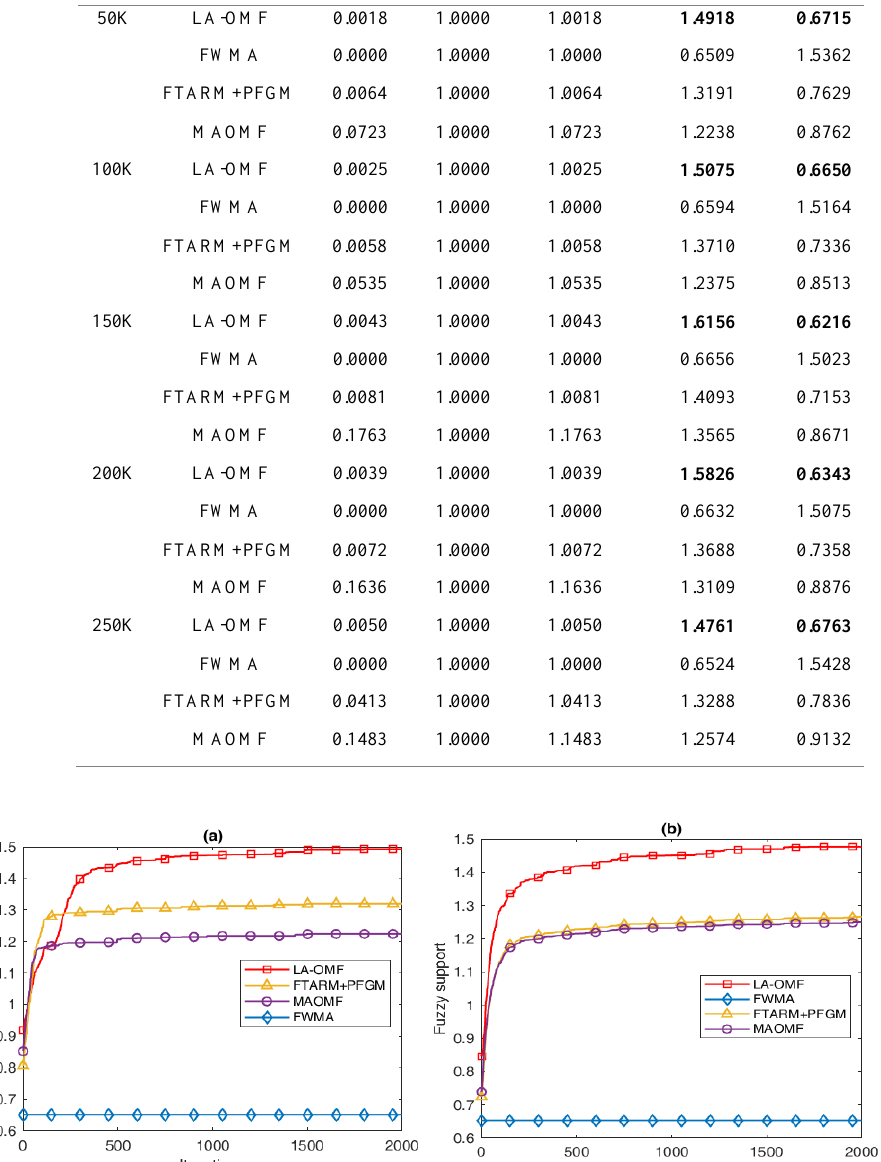
Figure 14. Change of fuzzy support along with different numbers of iterations for four test algorithms on different datasets. (a) 50k sessions and (b) 250k